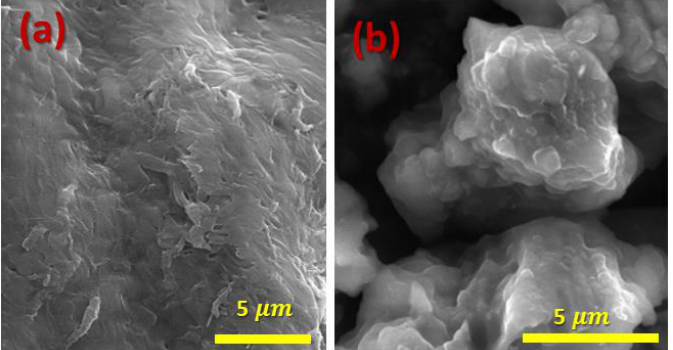
Fig. 4. FESEM images of (a) CS and (b)FEO-CS Fig.4: FESEM images of (a): CS and (b)FEO-CS nanocomposite